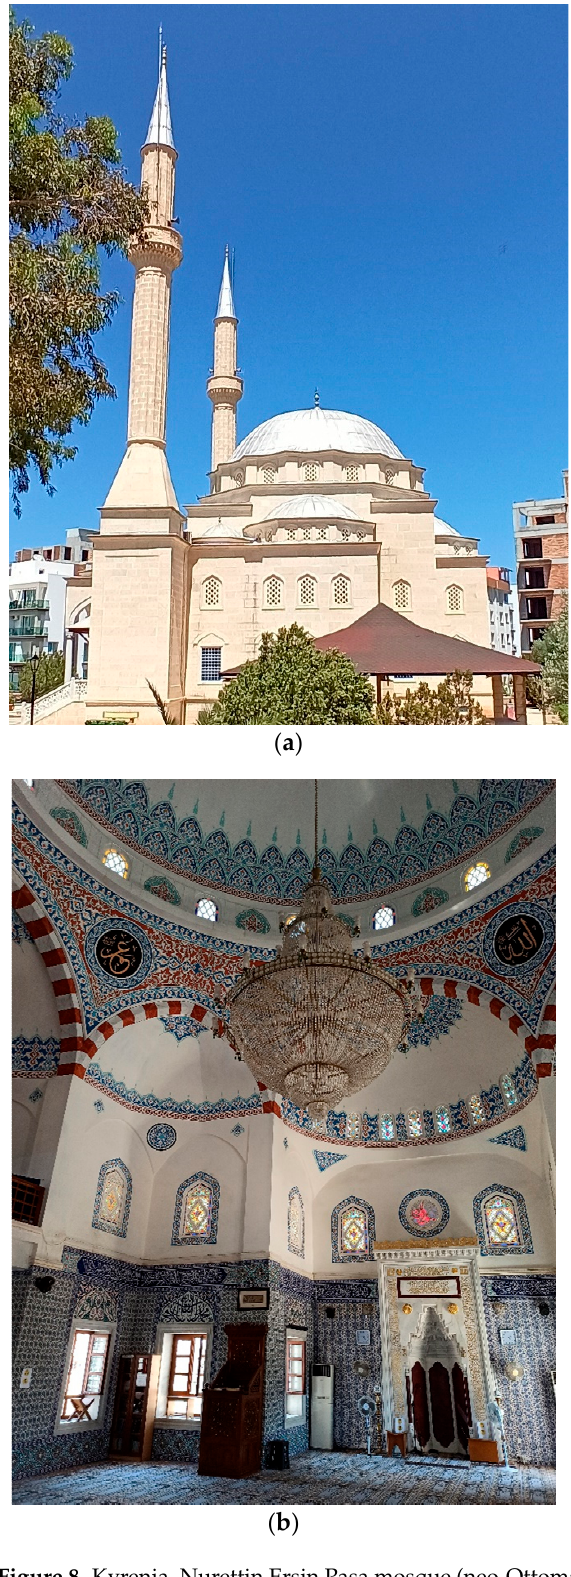
Figure 8. Kyrenia, Nurettin Ersin Pa ş a mosque (neo-Ottoman type), 1999: ( a ) west elevation; ( b ) view onto qibla and mihrab (photos: authors).